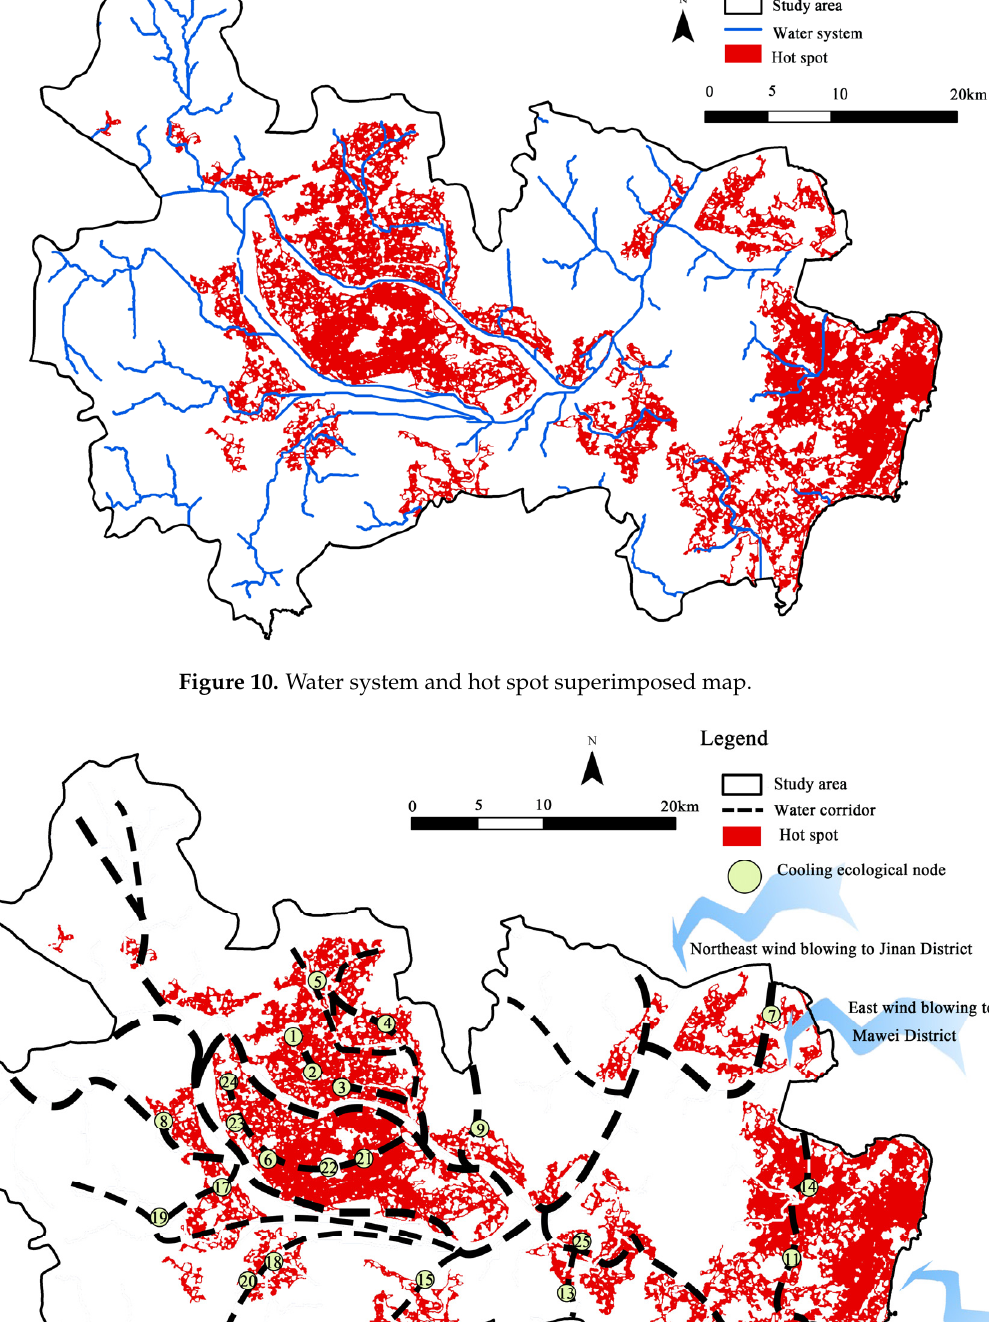
Table 5. Optimized corridor paths.